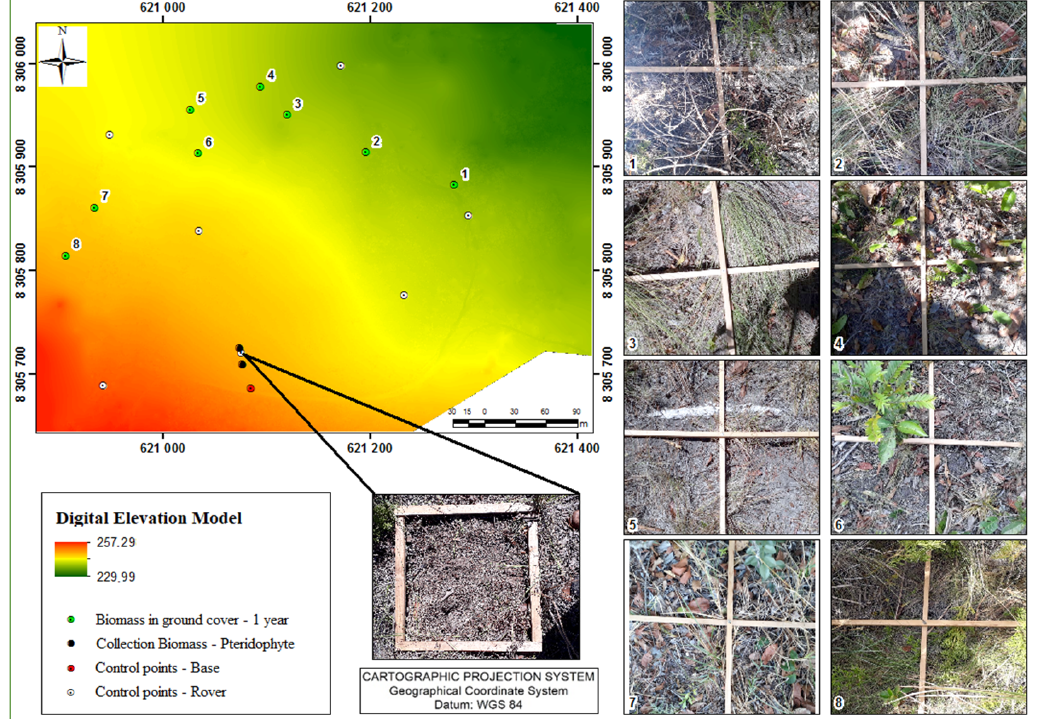
Figure 3. Digital Elevation Model (DEM) with the allocation of control points, biomass collection, and soil cover.